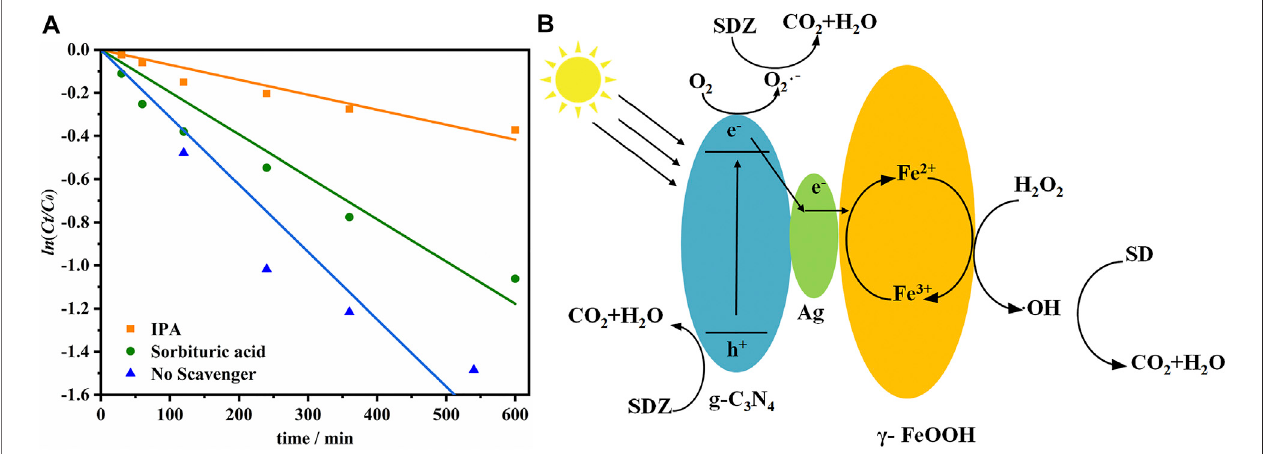
FIGURE 7 | (A) The effect of adding different quenchers on the degradation of SDZ, (B) Mechanism of catalytic degradation of SDZ.